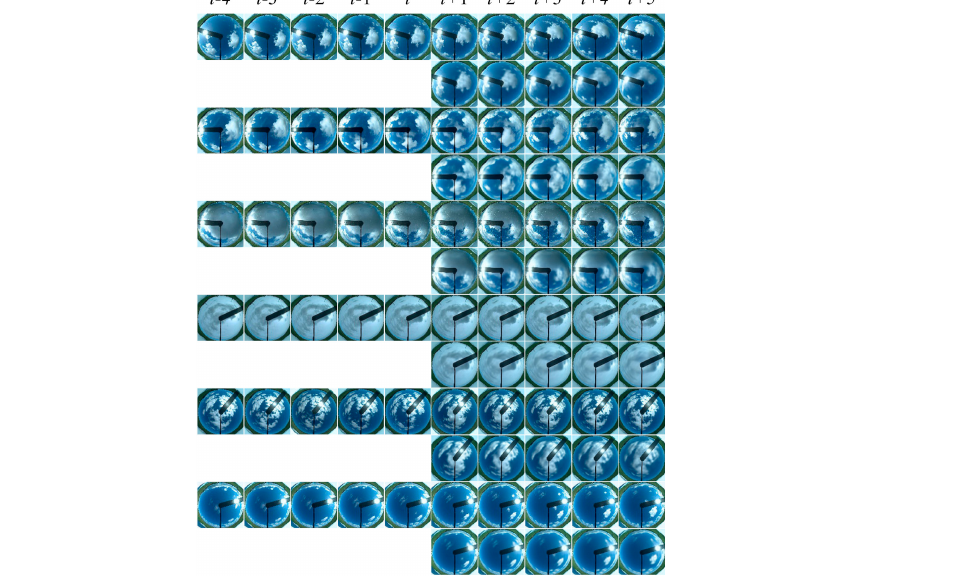
Figure 7. CCLSTM prediction results under downsampling. The total length of the sequence is 20 (input 10 and output 10), and only the 5th–15th are shown here. Let the current time be t . The left side of the first row of each sample is the historical cloud images from t -4 to t . The right side is the real cloud images from t + 1 to t + 5, and the corresponding position of the second row is the prediction results of the model from t + 1 to t + 5.